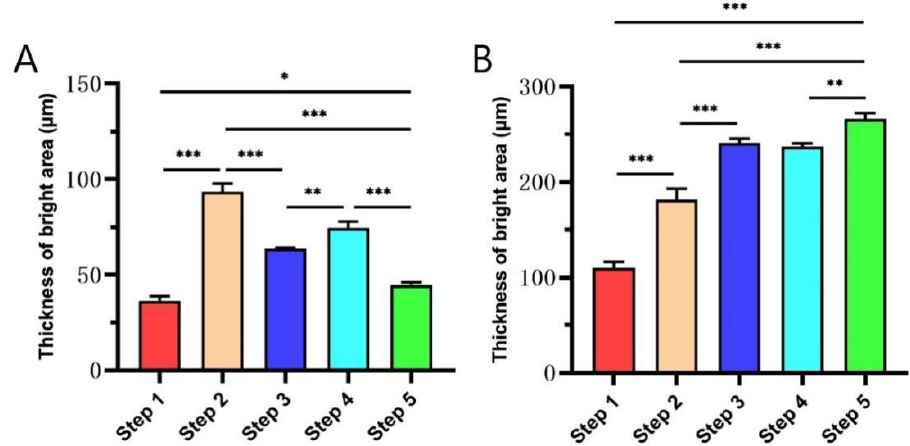
Figure 5. The thickness of the bright area of enamel ( A ) and dentin ( B ) in OCT images changed greatly in each step. * p < 0.05, ** p < 0.01, and *** p < 0.001.